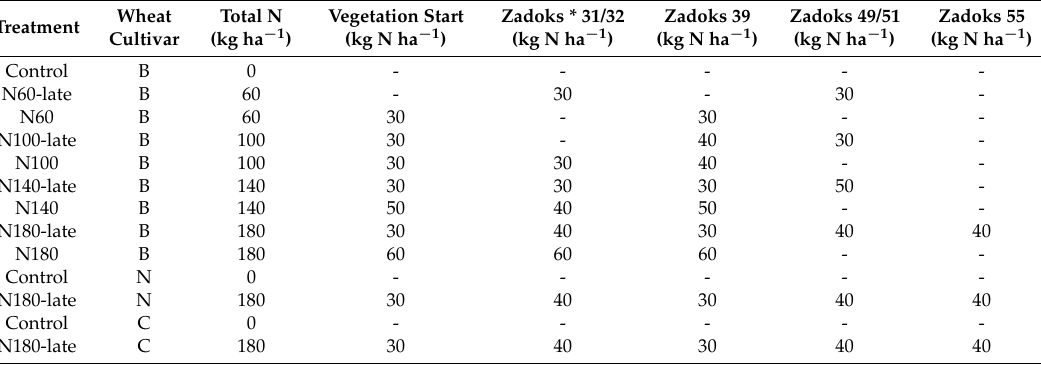
Table 1. Treatments of the conventional N trial differing in winter wheat cultivar (Bussard: B, Naturastar: N, Capo: C), amount of N fertilization, and temporal distribution of N fertilization.